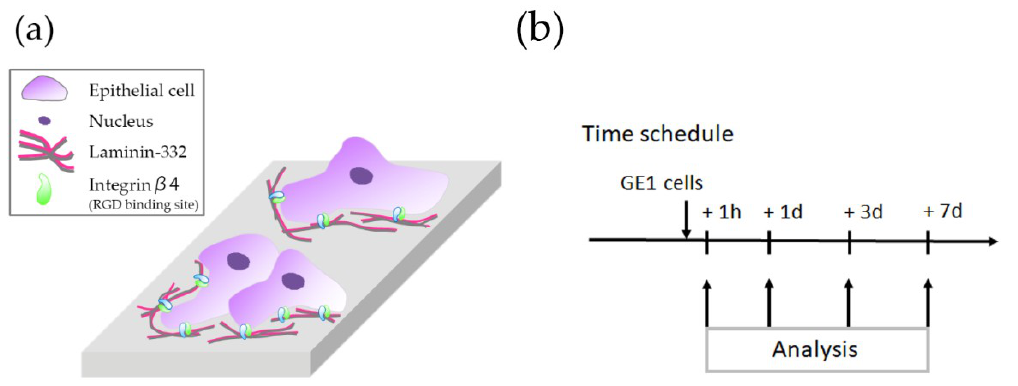
Figure 1. ( a ) Schematic diagram of the epithelial cells. ( b ) Experimental protocol for the Figure 1. (a) Schematic diagram of the epithelial cells. (b) Experimental protocol for the in vitro in vitro experiments.